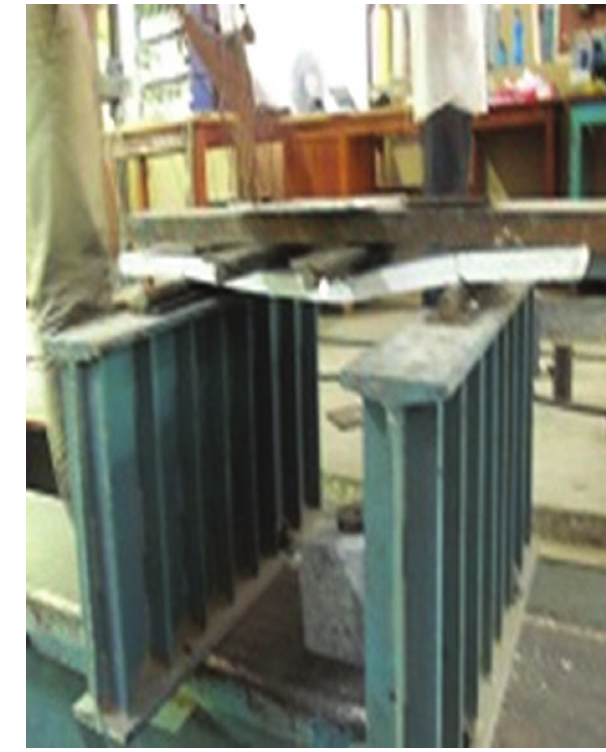
Figure 10 Typical failure of the